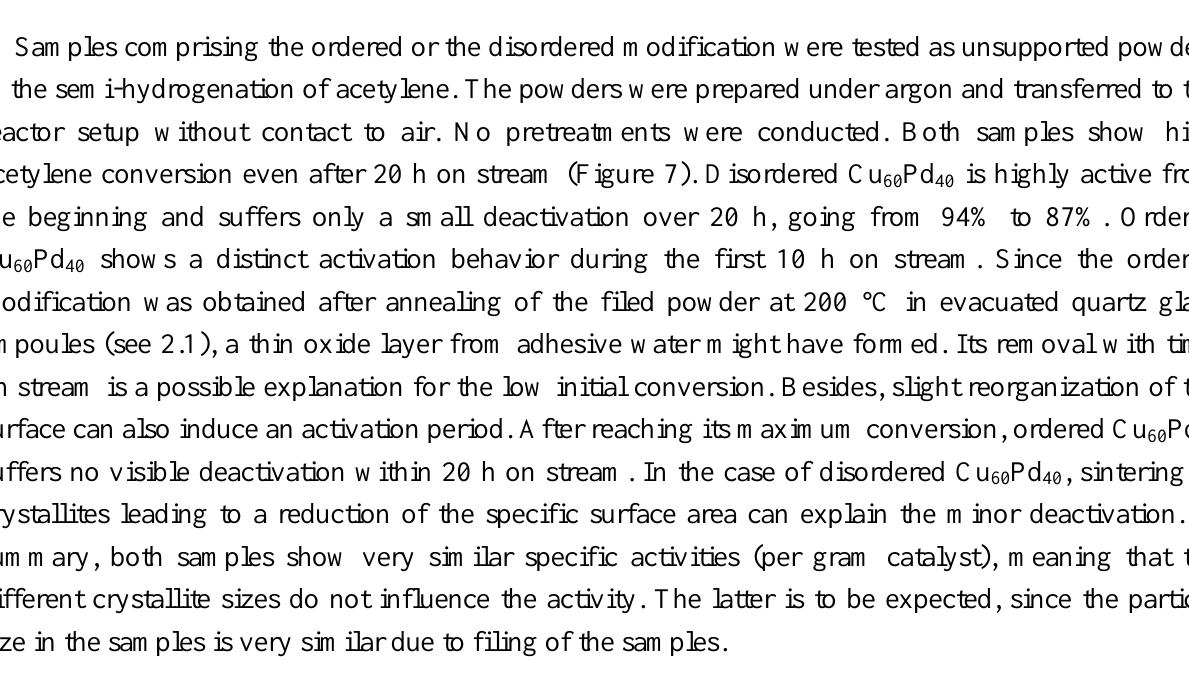
) set to zero). Pd contributions from both F